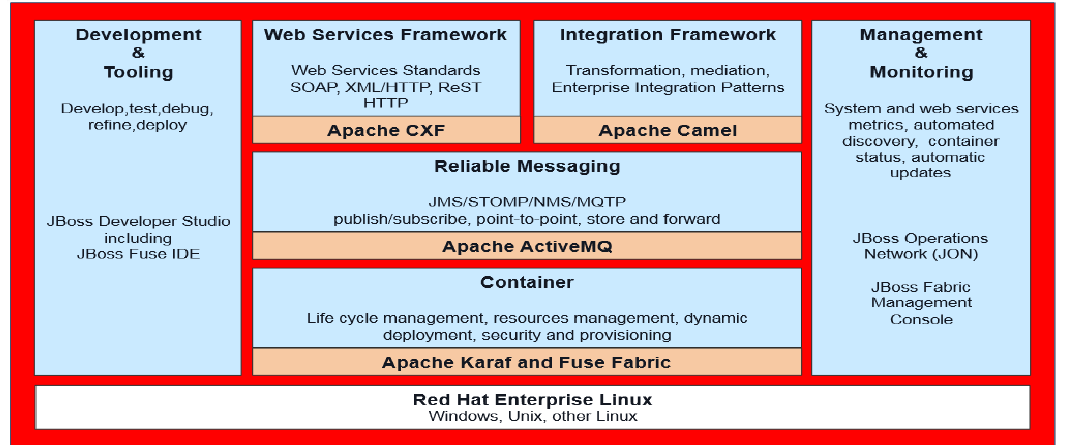
Figure 2: JBOSE Fuse